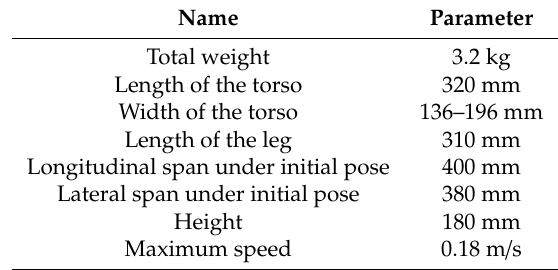
 . Figure 4 is the structure of modularized joint. Table 1. The structure parameters of the robot. Table 1. The structure parameters of the robot.